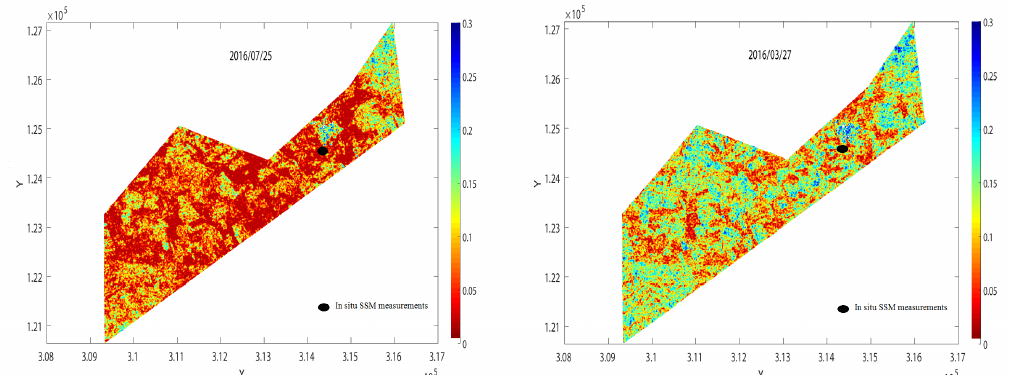
Figure 10. Mapping of soil moisture (vol.%) using support vector machine: dry ( left ) and wet ( right )